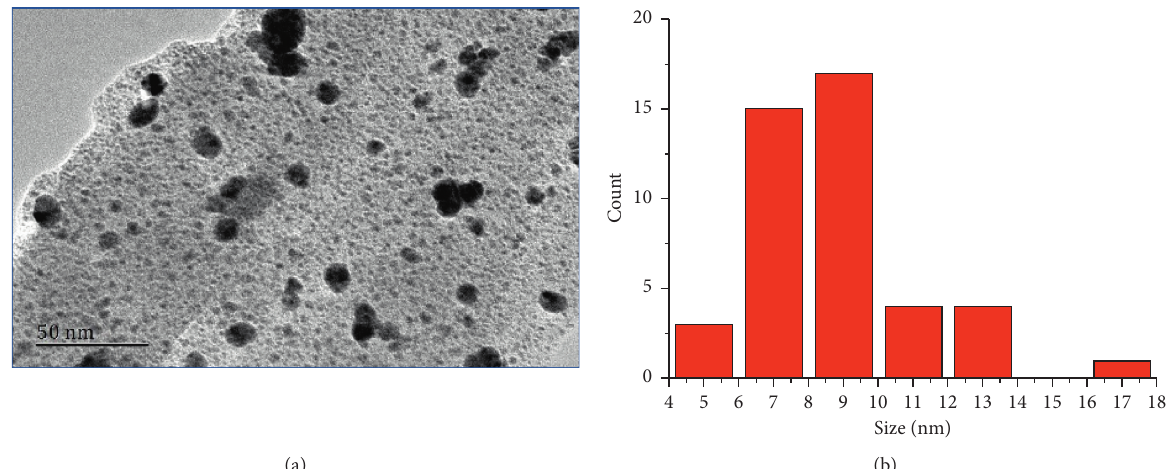
Figure 2: (a) TEM of CS/AuNPs. (b) The size distribution of CS/AuNPs.